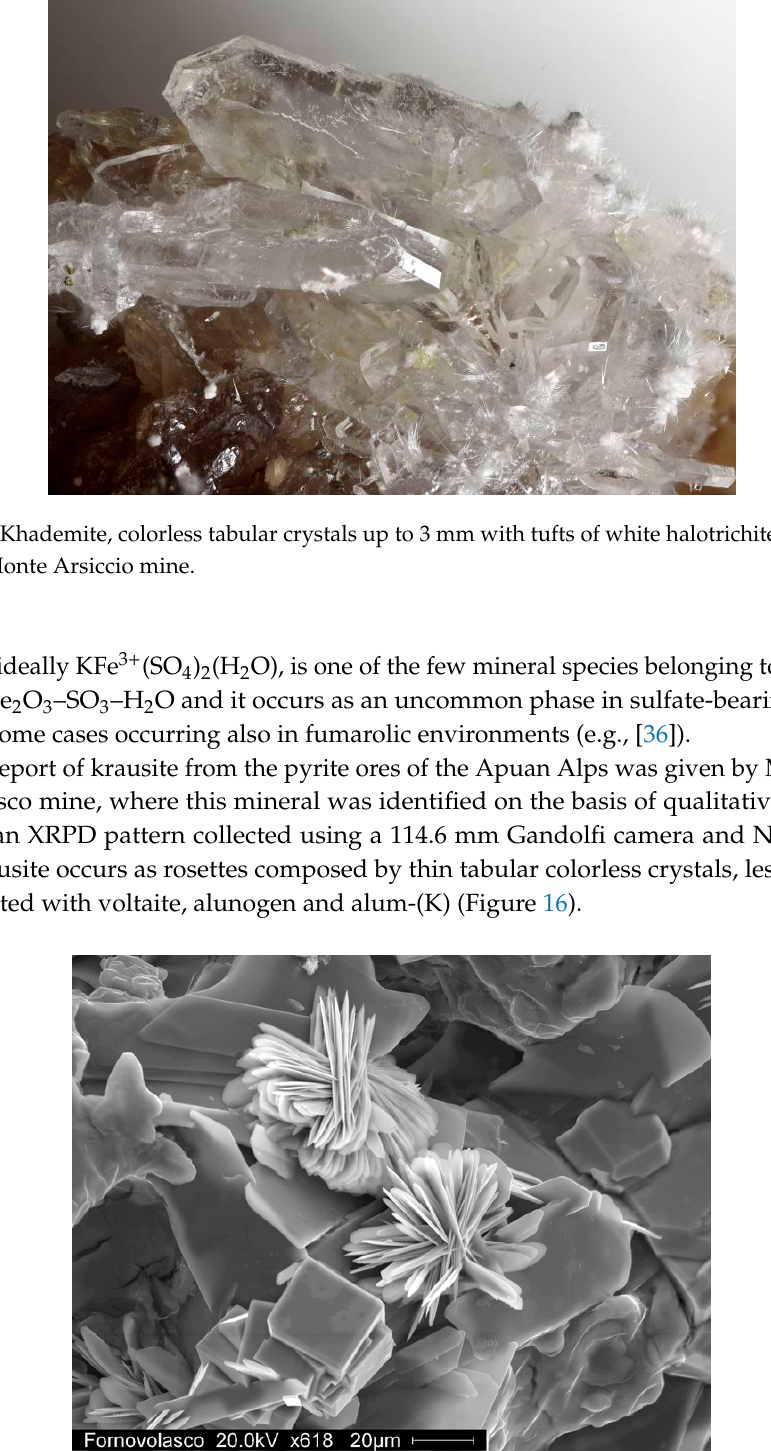
Figure 16. Krausite from the Fornovolasco mine, as rosettes of tabular crystals with alunogen and cubic voltaite.